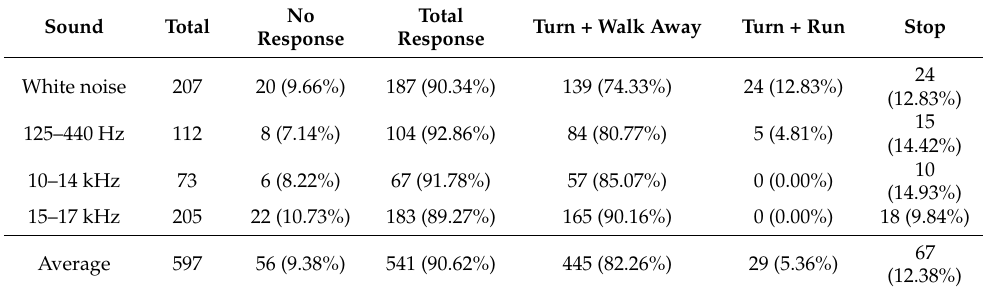
Table 2. Frequency bands and number of repetitions in trial